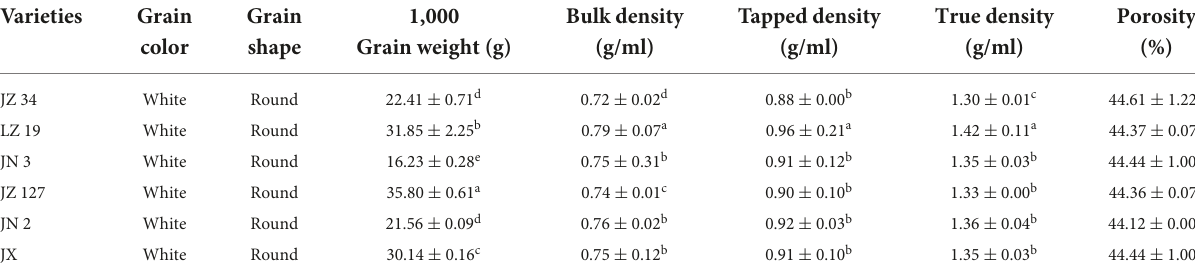
TABLE 1 Physical properties of sorghum grains.